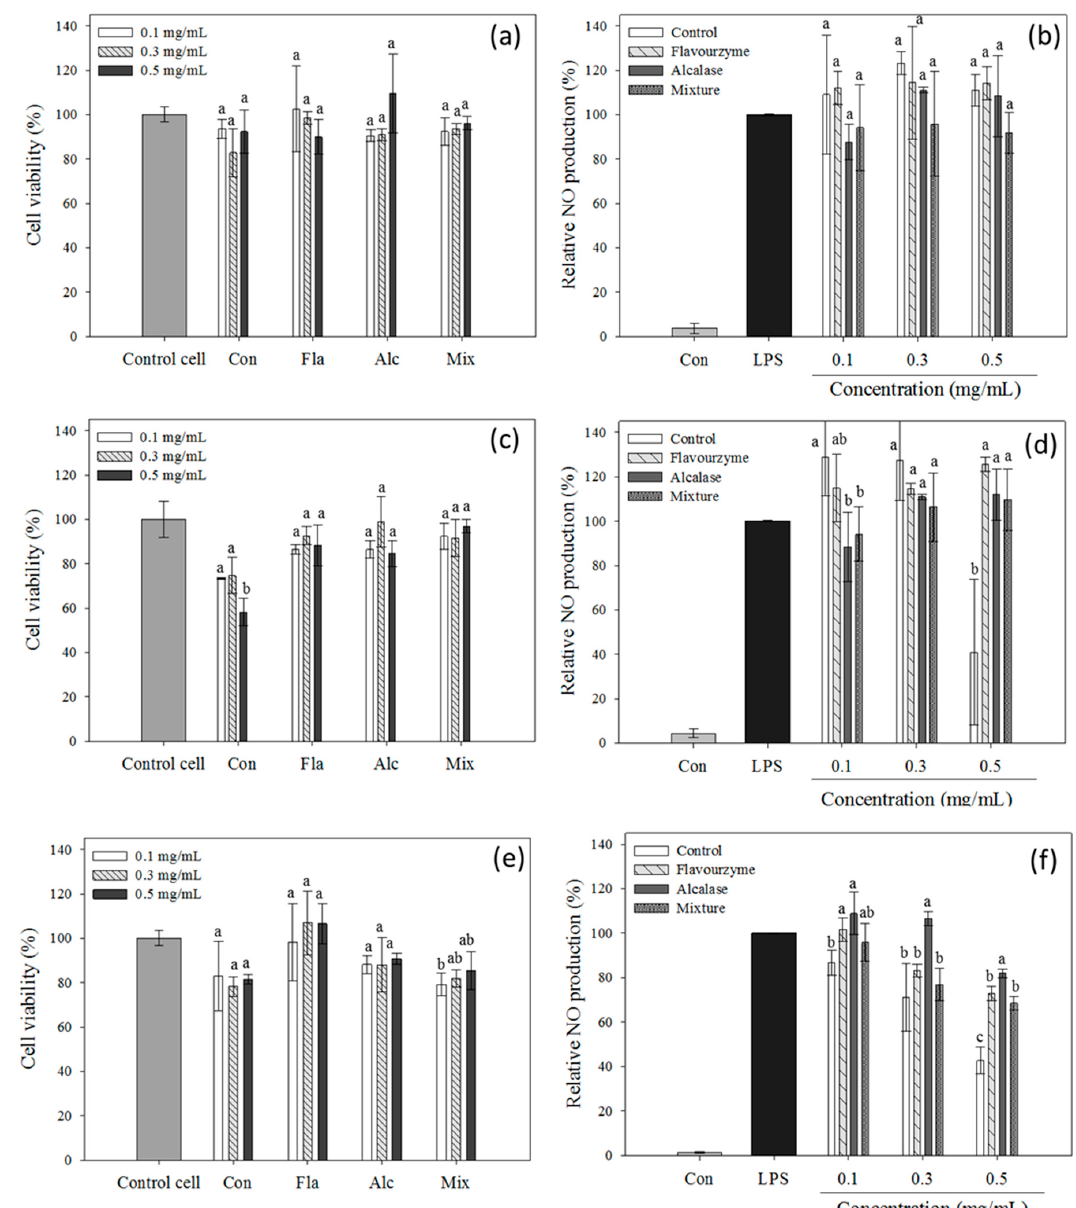
Figure 8. Cell viability ((a), (c), (e)) and nitric oxide (NO) production ((b), (d), (f)) from lipopolysaccharide (LPS)-induced RAW264.7 cells. Cells were treated with 100 ng/mL LPS and protein samples (unhydrolyzed or hydrolyzed insect proteins) and then NO production was measured. ( a ) effect on cell viability by mealworm larvae, ( b ) effect on NO production by mealworm larvae, ( c ) effect on cell viability by cricket, ( d ) effect on NO production by cricket; ( e ) effect on cell viability by silkworm pupae, ( f ) effect on NO production by silkworm pupae. Each value is expressed as the mean ± SD ( n = 3); different letters indicate significant differences among treated groups ( p < 0.05).